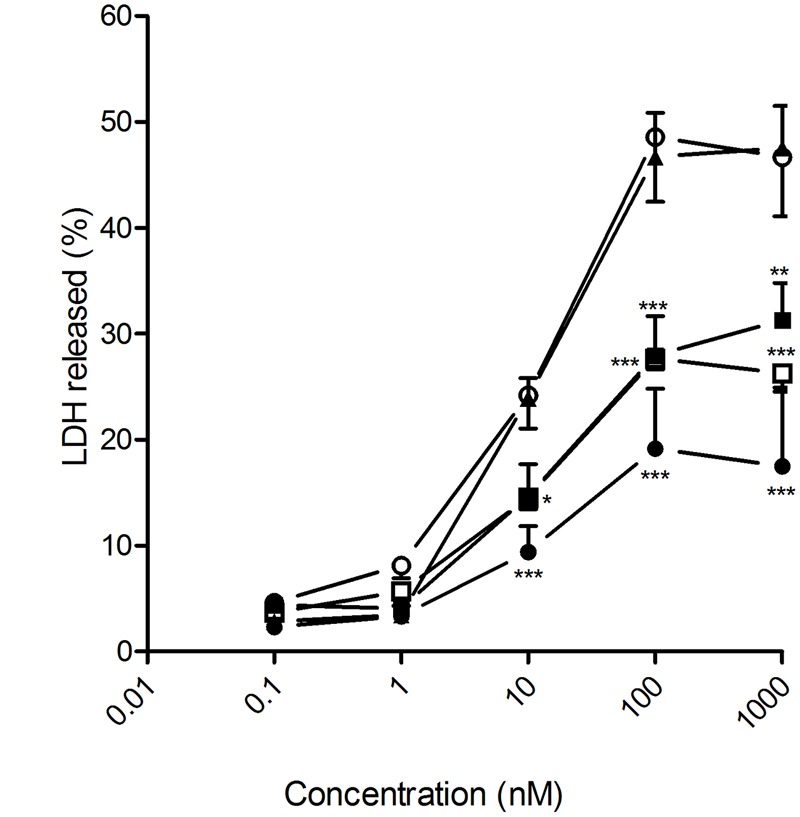
Antitumoral effect of free and encapsulated docetaxel on rat glioblastoma C6 cancer cells. C6 cancer cells were exposed to increasing concentrations of either free DTX (▲) or docetaxel encapsulated in heterodimer 1 nanocapsules (○); heterodimer 1 nanospheres (□); heterodimer 2 nanocapsules (●) or heterodimer 2 nanospheres (■) for 72 h. LDH release to the medium was considered an index of cellular death. Data represent mean ± SEM of 20 to 32 cells. ∗p < 0.05, ∗∗p < 0.01, ∗∗∗p < 0.001when compared to free DTX.